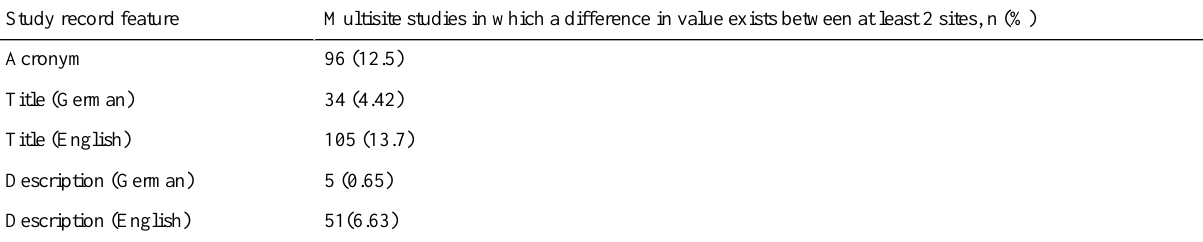
Table 4. Multisite studies in which a difference in value was present between at least 2 site-local study records. For example, in 34 of the 769 multisite studies, there were 2 or more different values for the German study